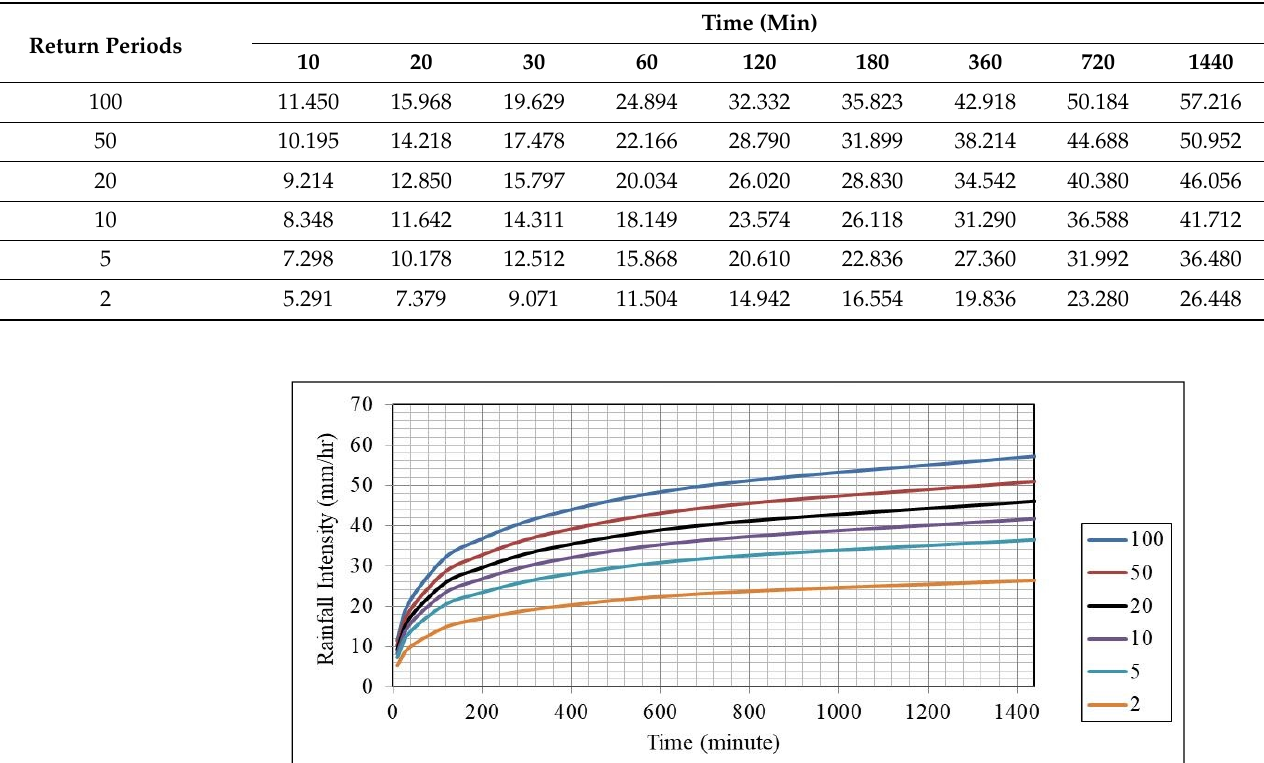
Figure 6. Curve values (intensity, duration, and frequency) for the study station.